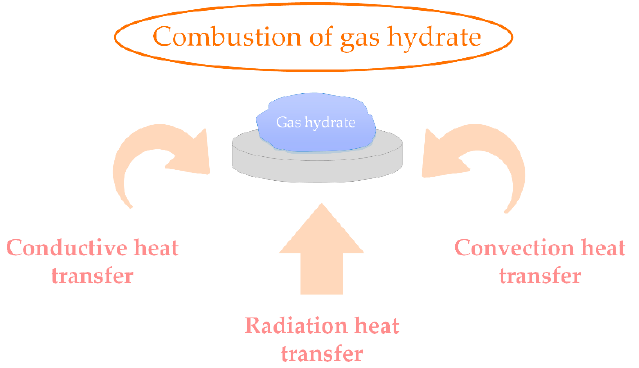
Figure 3. Scheme of the heat supply for gas hydrate combustion initiation.